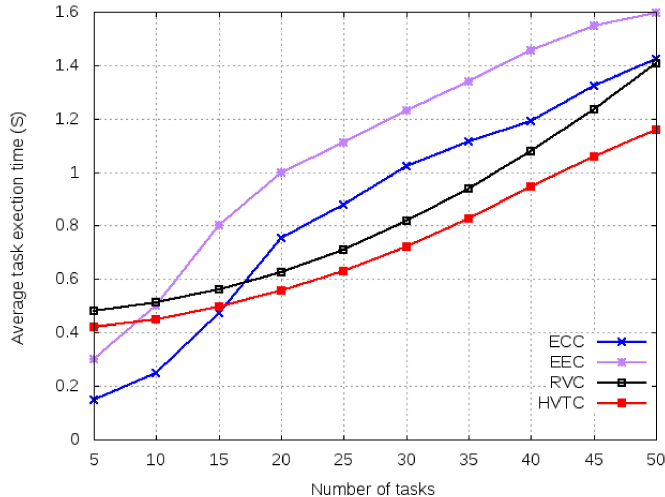
Figure 6. Average execution time for a varied number of